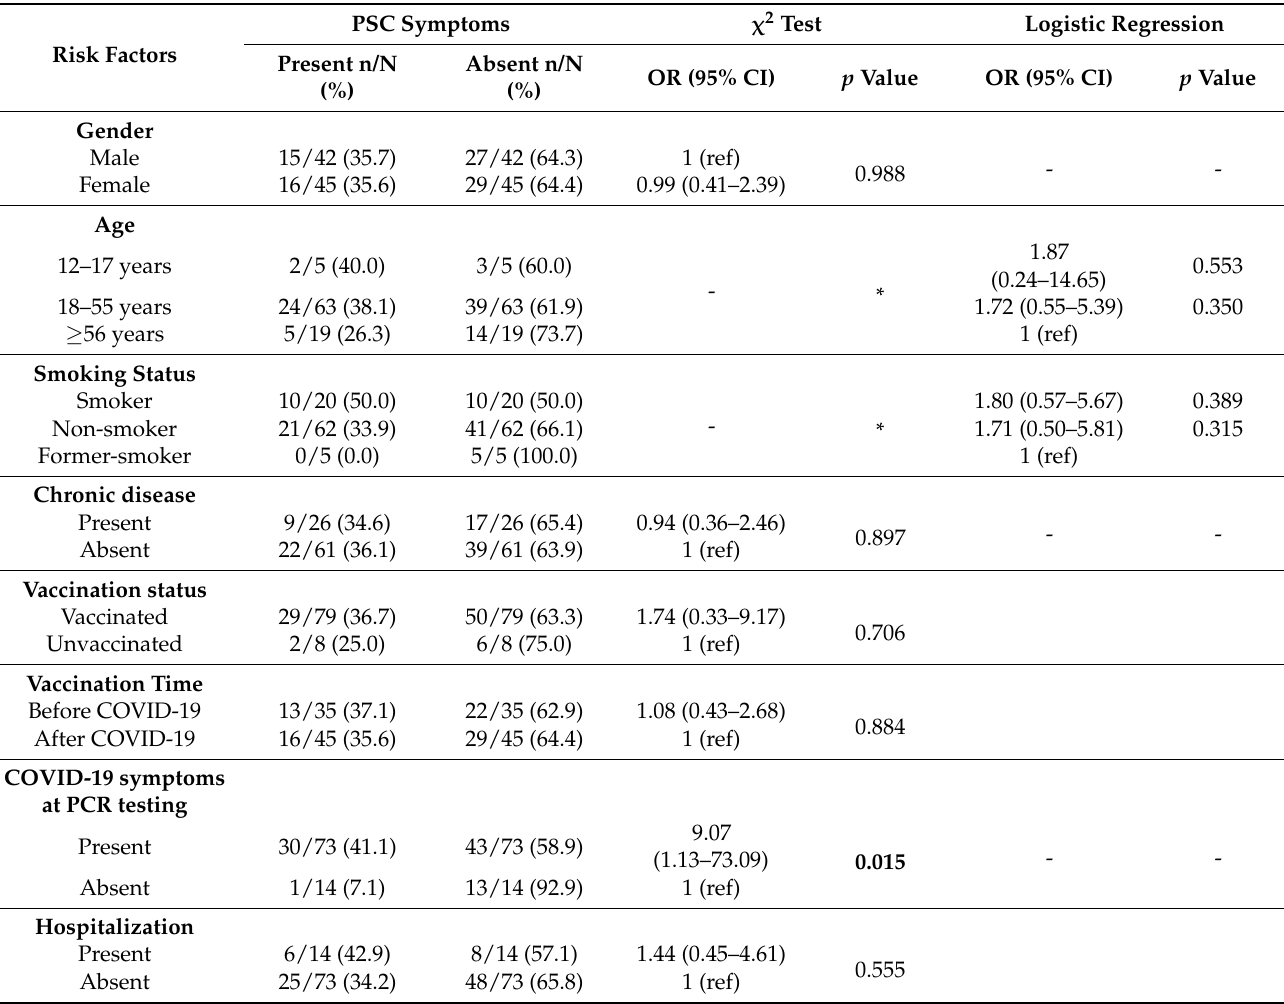
Table 4. Risk factors associated with PSC syndrome in Gr2. Abbreviations: OR, odds ratio; CI, confidence interval; ref, reference value; *, chi square statistics could not be calculated. Significant p values were indicated with bold to assist the